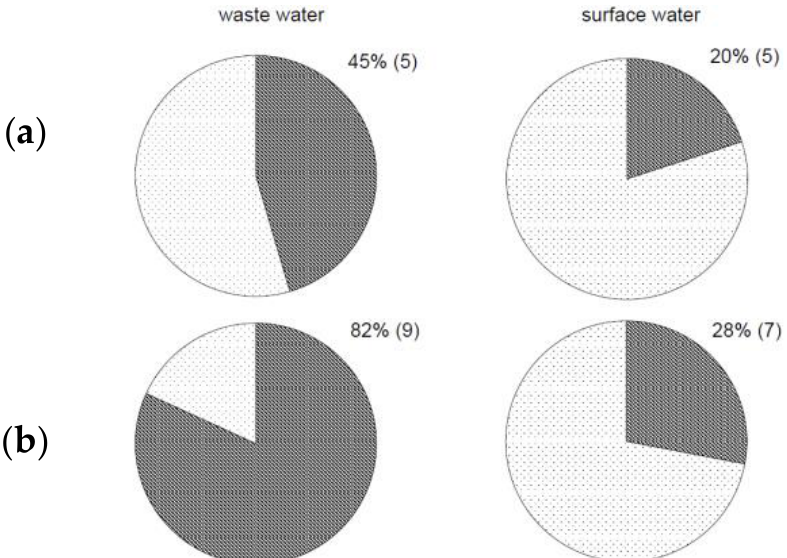
Figure 2. Comparison of detection of thermotolerant campylobacters from water samples. Percentage (number) of Campylobacter -positive samples from wastewater (left charts) and surface water (right charts). Isolation and detection of C. jejuni and C. coli by ( a ) standard ISO 17995 method and ( b ) alternative method. Positive samples shown in dark colour.